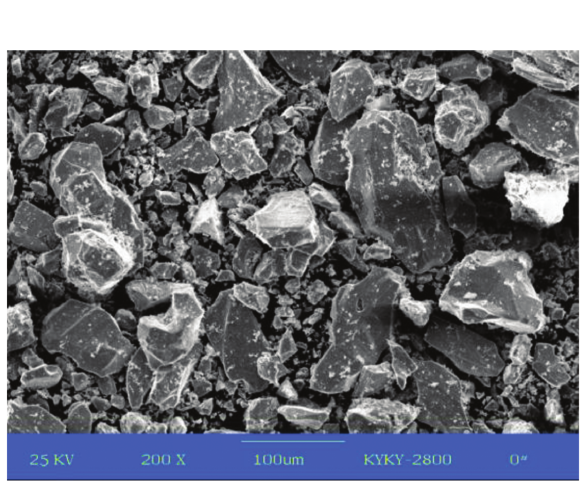
Figure 1: Particles morphologies of specularite fines under SEM.